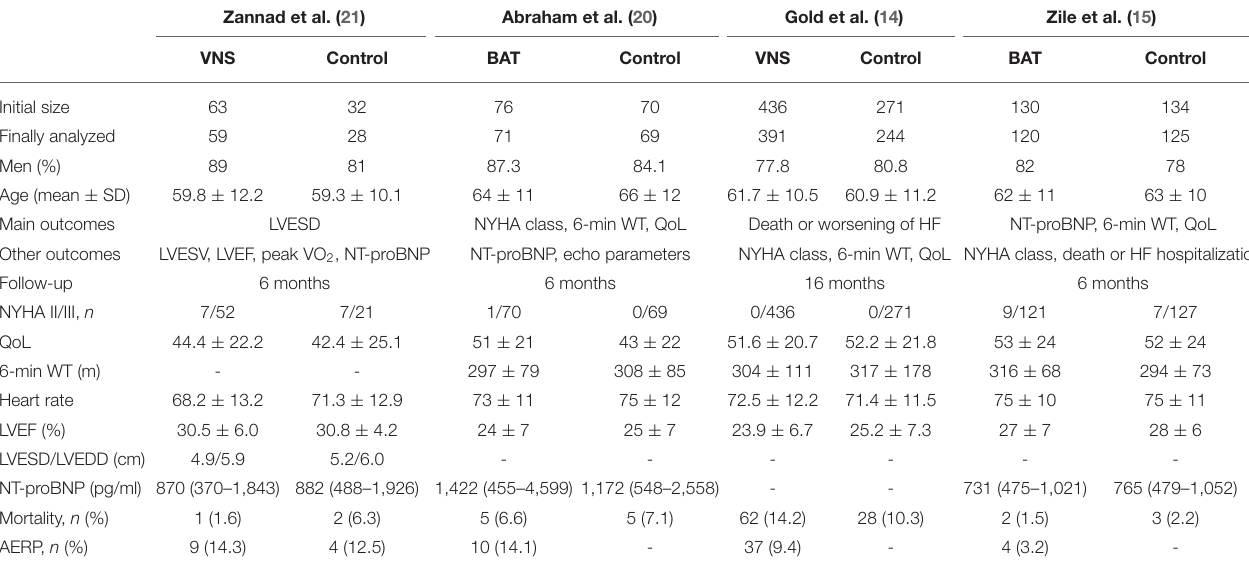
TABLE 4 | Initial data of the randomized controlled trials.